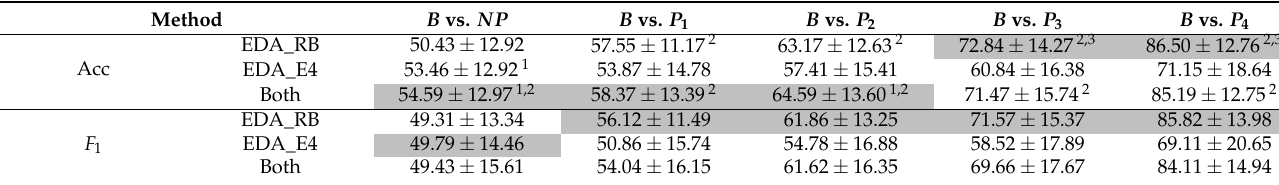
Table 8. 5 × LOSO average performance using different EDA sensor combinations of the PMDB with an MLP + Random Forest (RF) classifier. The best performing approach is highlighted in grey. Moreover, a paired student’s t -test with a significance level of 5% was performed to check the significance in differences between the accuracies obtained by each pair of approaches for each classification problem. 1,2,3 indicate a significant improvement compared to the EDA_RB, EDA_E4, and fusion approaches, respectively.